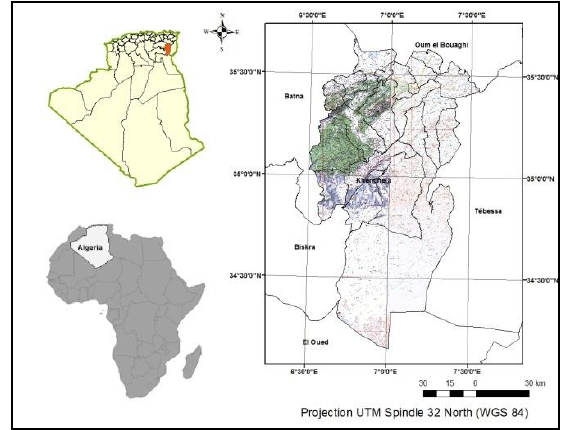
Figure 1. Geographic situation of study region.